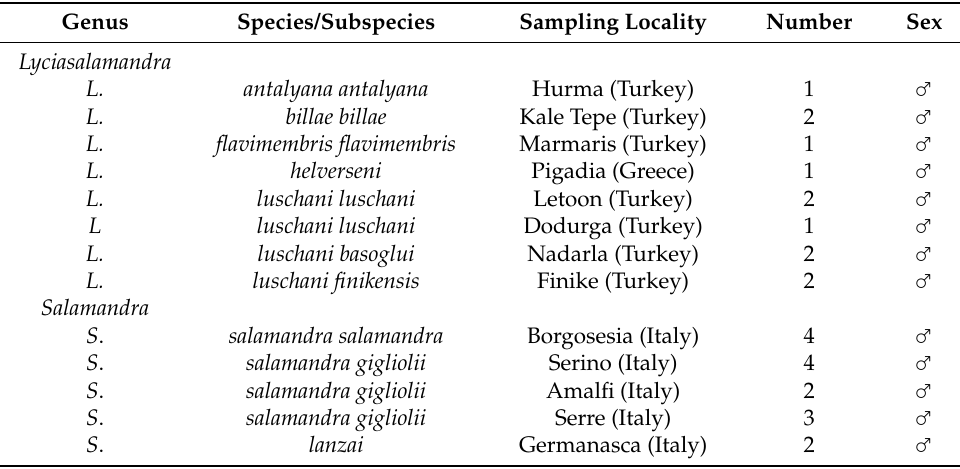
Table 1. Taxonomic attribution, sex and origin of the samples